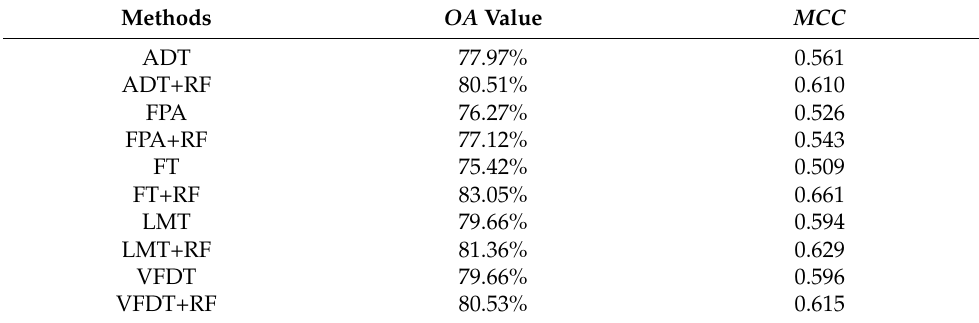
Table 4. Performance of different